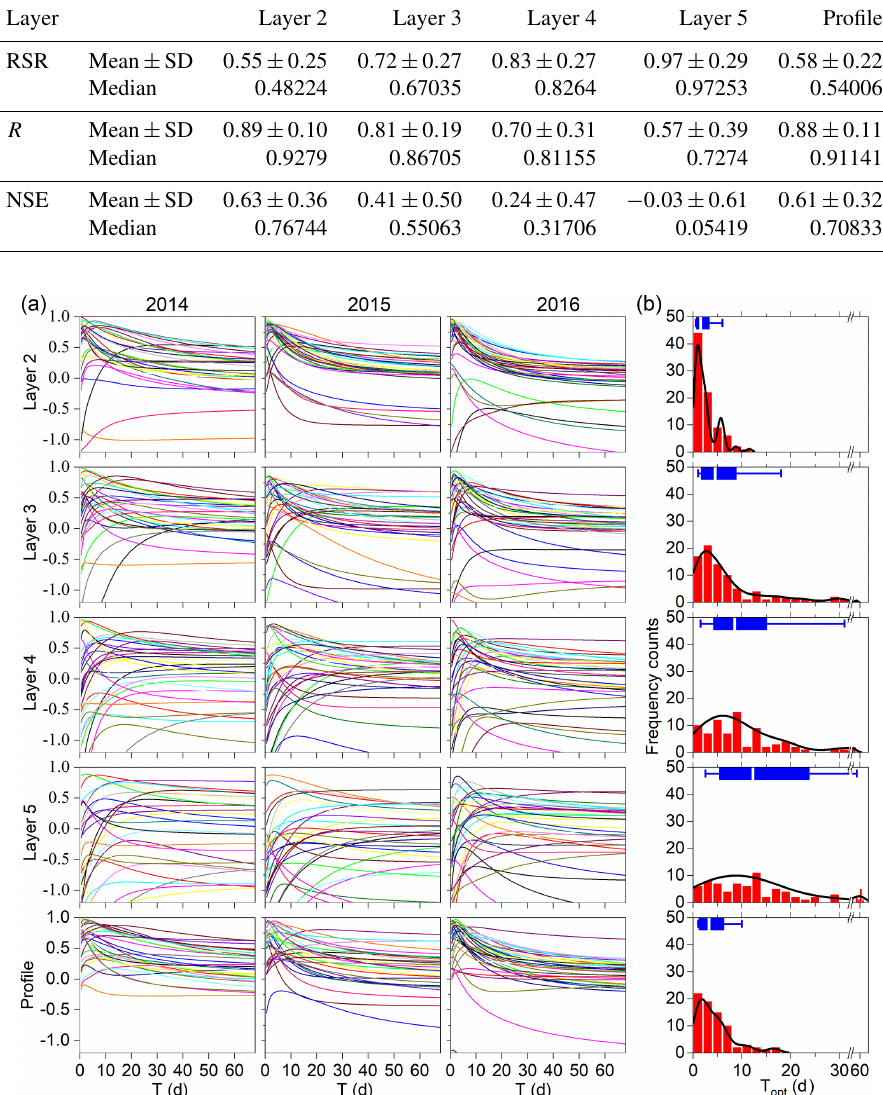
Figure 4. Variation of NSE with T of the exponential filter method for different layers at each station during the growing seasons of 2014, 2015, and 2016. The vertical axis is the NSE value. The frequency distribution curve and histogram show the distribution of T opt with depth for all